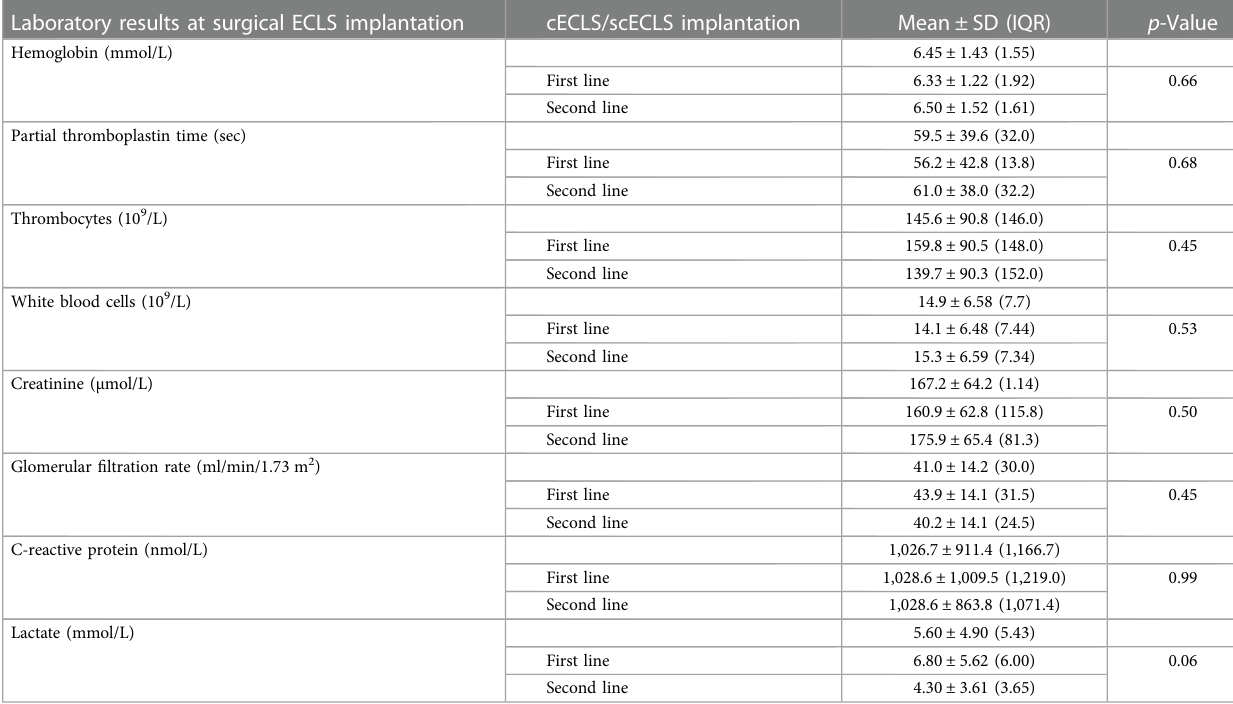
TABLE 4 Laboratory fi ndings.